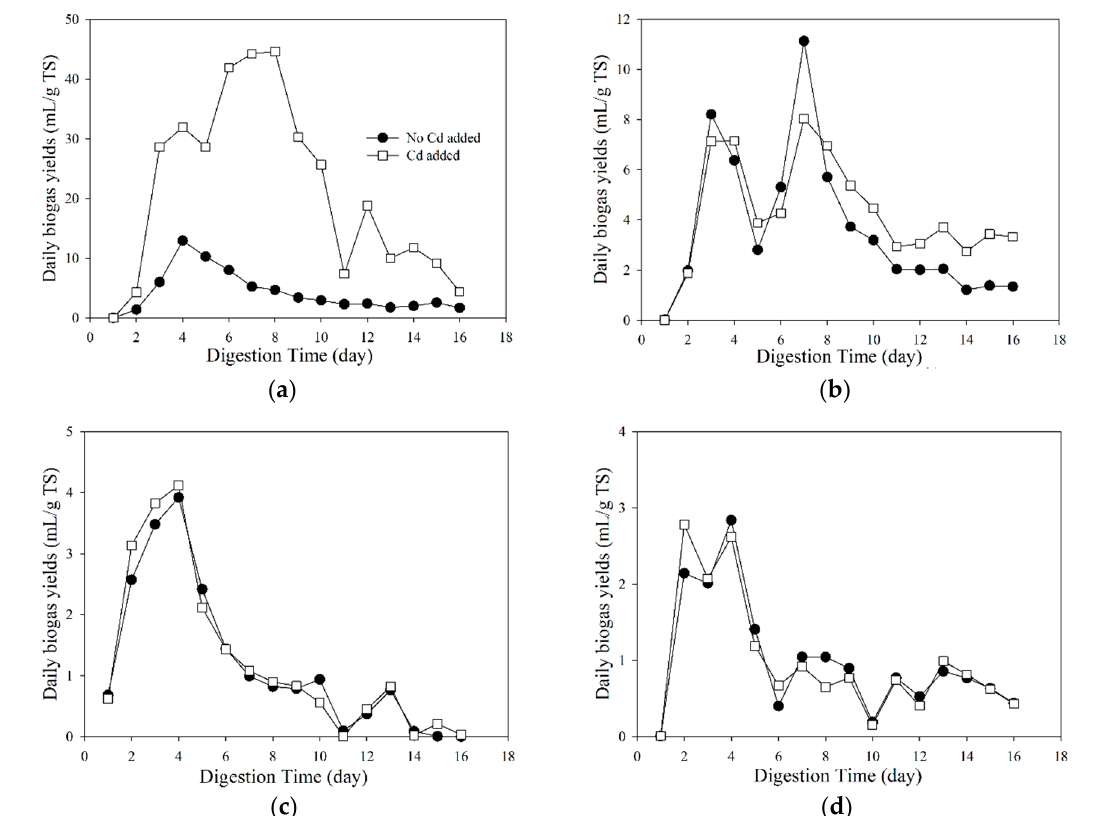
Figure 3. Daily biogas yields under Cd stress with digestion temperatures of 55 °C ( a ), 45 °C ( b ), 35 °C ( c ), and 25 °C ( d ).